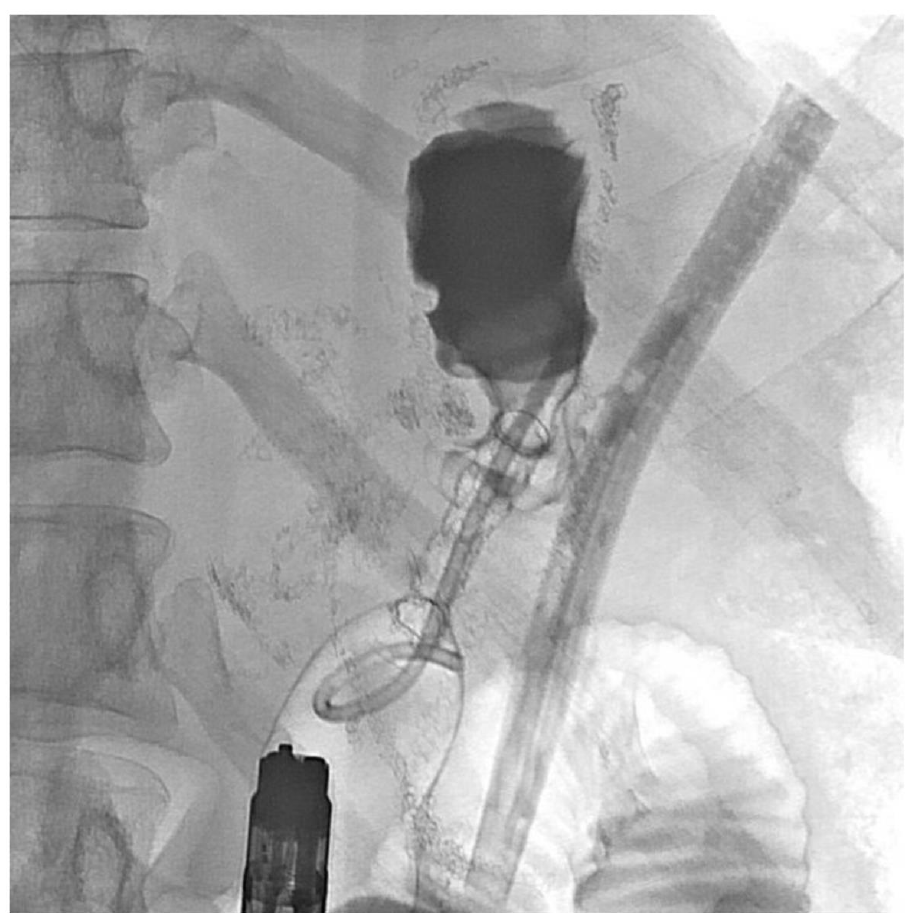
Figure 19. Pigtail stent through covered stent (fluoroscopic view).